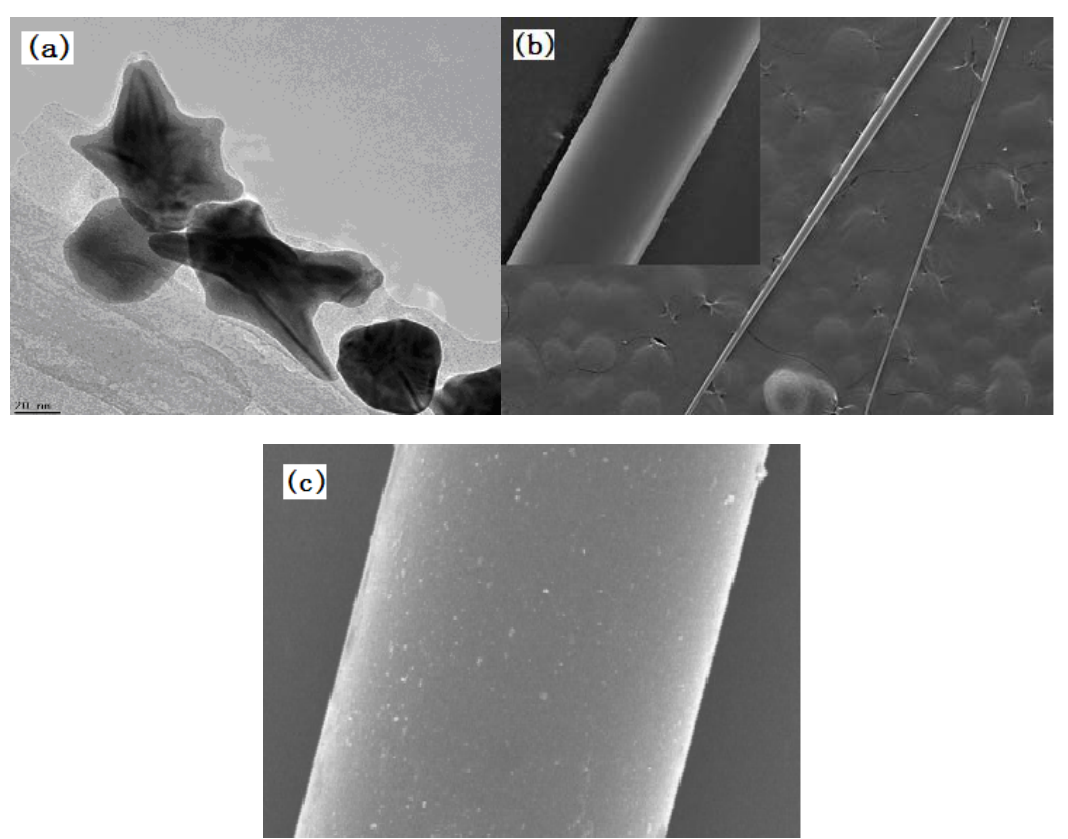
Figure 5. ( a ) TEM image of the star-shaped gold nanoparticles; ( b ) SEM image of the naked tapered fiber; and ( c ) SEM image of the tapered fiber modified with the